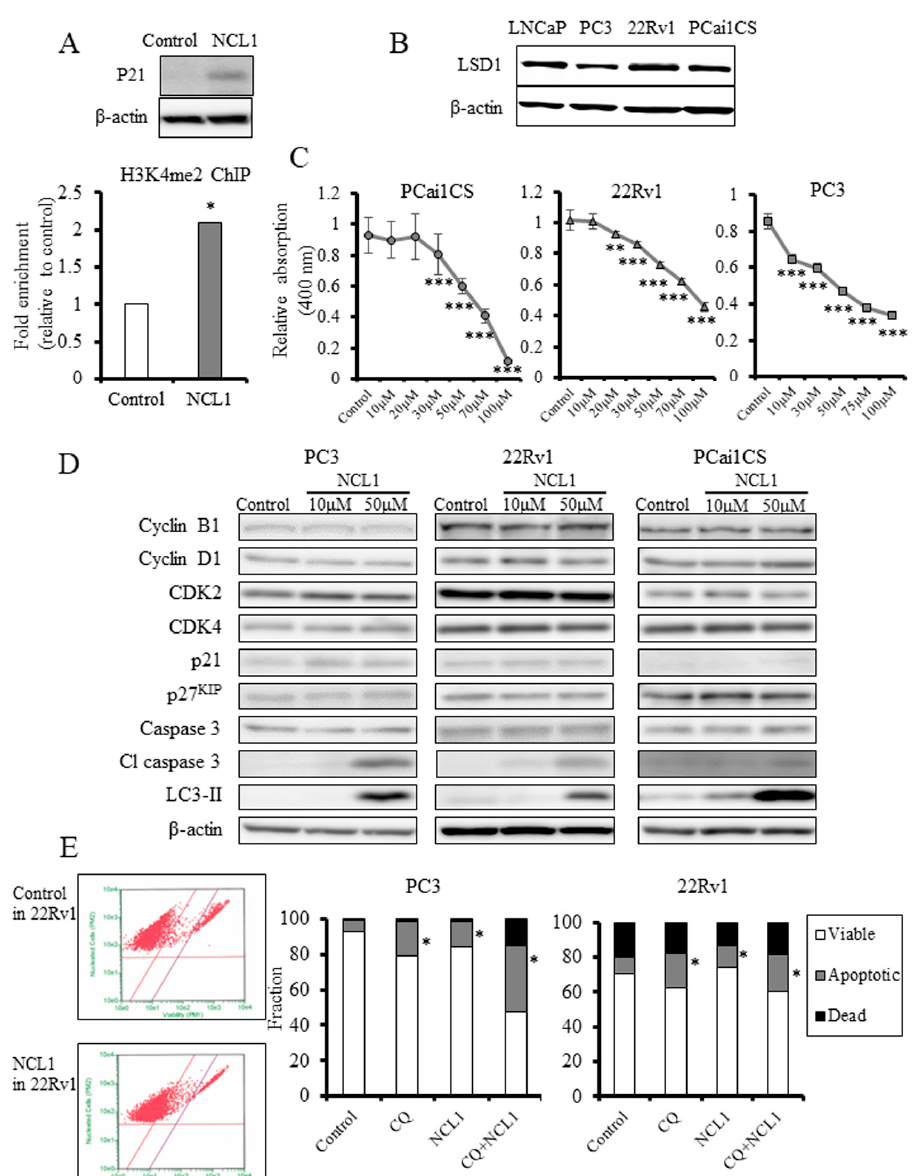
Figure 2. ( A ) Chromatin immunoprecipitation (ChIP) analysis in 22Rv1 cells using a histone H3 lysine 4 dimethylation (H3K4me2) antibody showed that NCL1 induced the attenuation of demethylation of H3K4me2 in the promoter regions of P21. Western blot analysis of P21 in 22Rv1 cells is shown. The protein expression of P21 was increased, reflecting the results of the ChIP analysis. β -actin was used as an internal loading control. ( B ) Western blot analysis of PCai1CS, 22Rv1, and PC3 cells for LSD1. All castration-resistant prostate cancer (CRPC) cell lines expressed LSD1. β -actin was used as an internal loading control. ( C ) PCai1CS and 22Rv1 cells were treated with vehicle (control) or NCL1, and subjected to WST-8 assay to measure cell proliferation. NCL1 treatment reduced the cell viability of the two CRPC cell lines in a dose-dependent manner. ( D ) Western blot analyses 48 h after NCL1 treatment of 22Rv1, PCai1CS, and PC3 cells. The cell cycle-related protein expression of cyclin B1, cyclin D1, CDK2, CDK4, and p27 KIP were unchanged. Treatment with NCL1 resulted in a marked elevation in cleaved caspase 3 without any change in caspase 3. In addition, protein expression of microtubule-associated protein light chain 3 (LC3)-II was elevated in NCL1-treated CRPC cells. β -actin was used as an internal loading control. ( E ) Guava ® apoptosis analysis of PC3 and 22Rv1 cells. NCL1, the autophagy inhibitor chloroquine (CQ), and a combination of these drugs induced apoptosis in CRPC cells. Mean ± standard deviation (SD); * p < 0.05, ** p < 0.001, *** p <